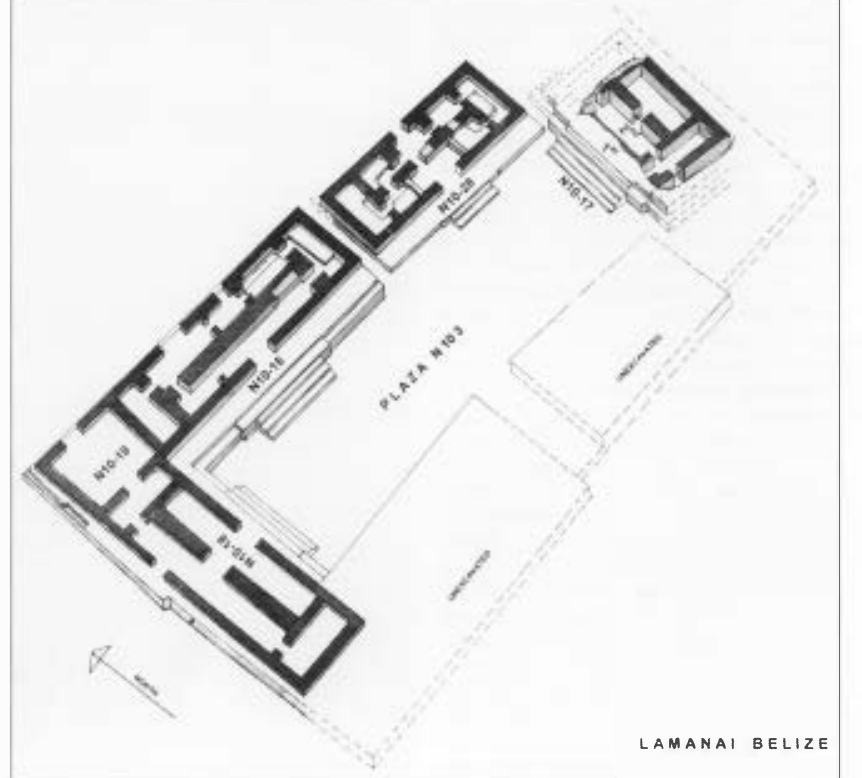
Figure 4 Plan of the Ottawa Group of buildings at the end of the Classic Period (in the early ninth century AD) based on the excavations to